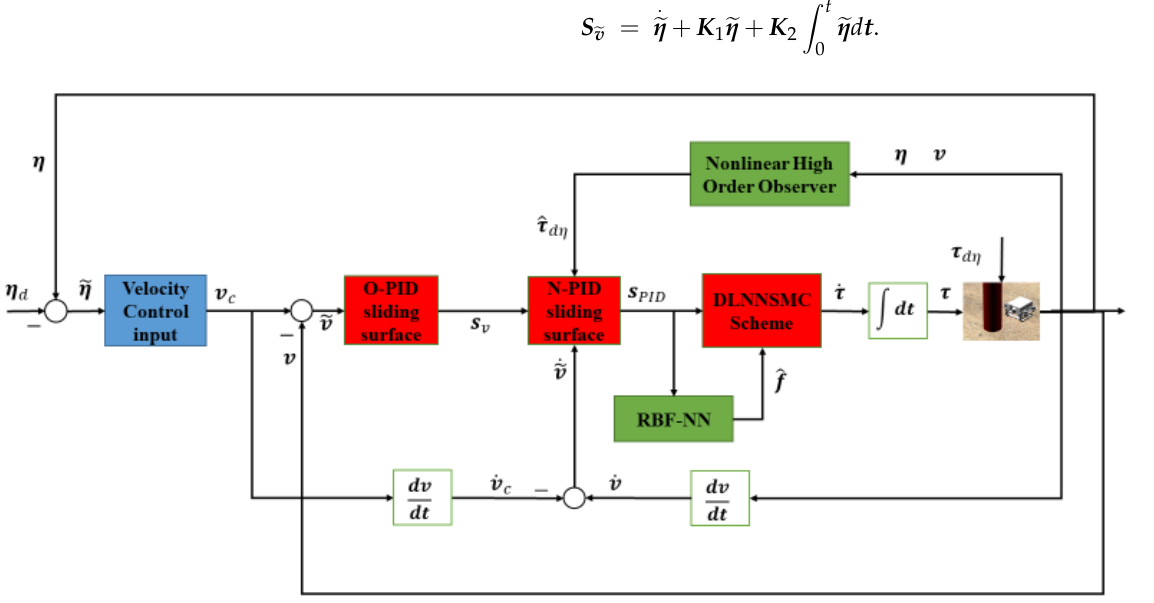
Figure 2. Structural framework of the double-loop neural network proportional–integral–derivative (PID) sliding mode control scheme.